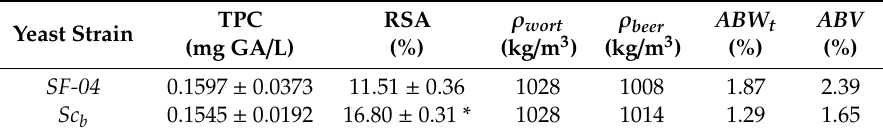
Table 2. Total phenolic content (TPC) determined by the Folin–Ciocalteu method and expressed in mg of gallic acid (GA) per L, antioxidant activity (RSA) obtained by the stable free radical 2,2-Diphenyl-1-picrylhydrazyl (DPPH) technique and expressed in % by Equation (1), wort density ( (cid:37) wort ), beer density ( (cid:37) beer ), alcohol percentage by weight (ABW t ) and by volume (ABV) of the craft beer fermented with Saccharomyces cerevisiae ( Sc ) and Saccharomyces cerevisiae var. boulardii (SF-04) yeast strains. Results of TPC and RSA shown as mean ± standard deviation. * Statistically significant di ff erences ( p < 0.05). TPC RSA Yeast Strain (mg GA / L)